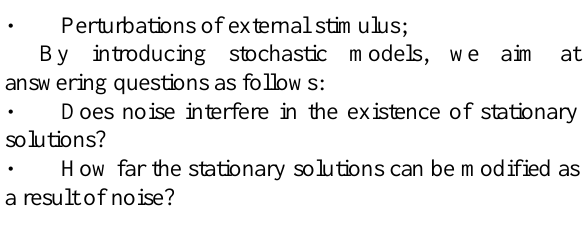
Figure 4. Input function corresponding to a traveling wave, moving in the direction of the X axis